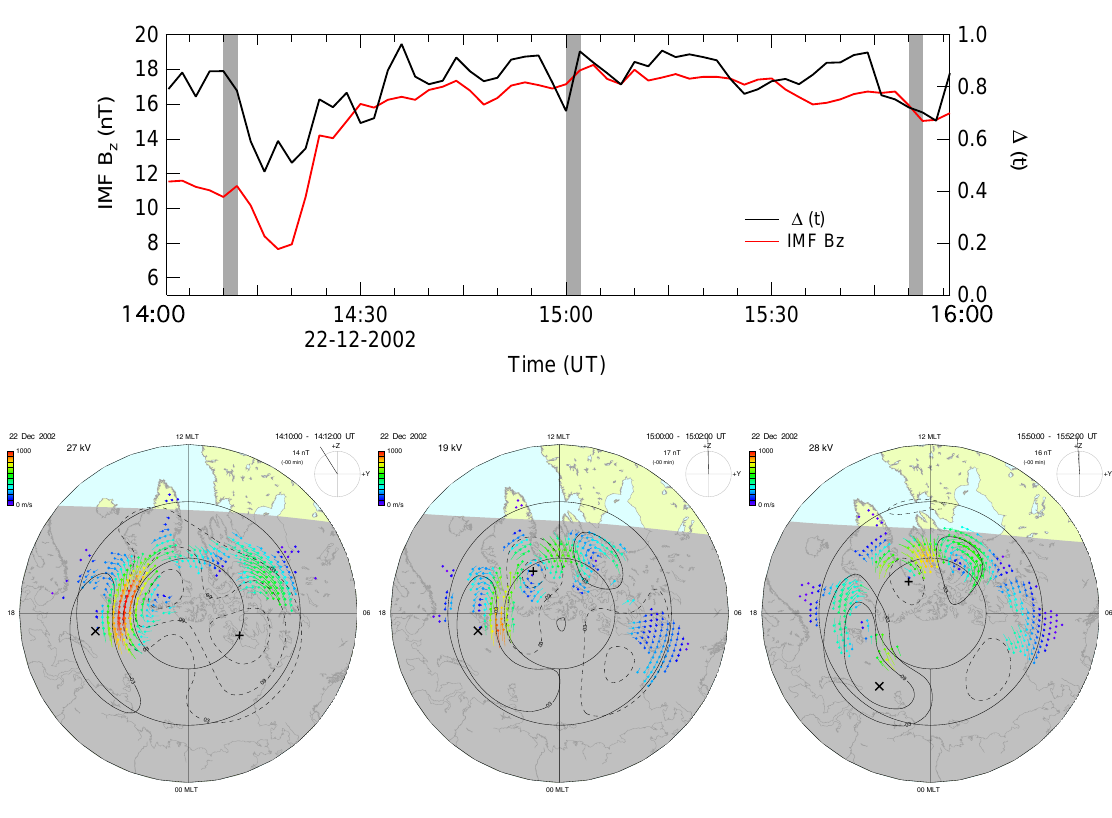
Fig. 2. Upper panel: IMF B z (red, axis on the left), as obtained by OMNI, and normalised disorder degree Δ( t ) (black, axis on the right) for the period 22/12/2002, 14:00 – 16:00 UT. Lower panel: three samples of SuperDARN convection maps for the same period; the 2-minute scan intervals represented in the maps are shaded in the upper panel plot.